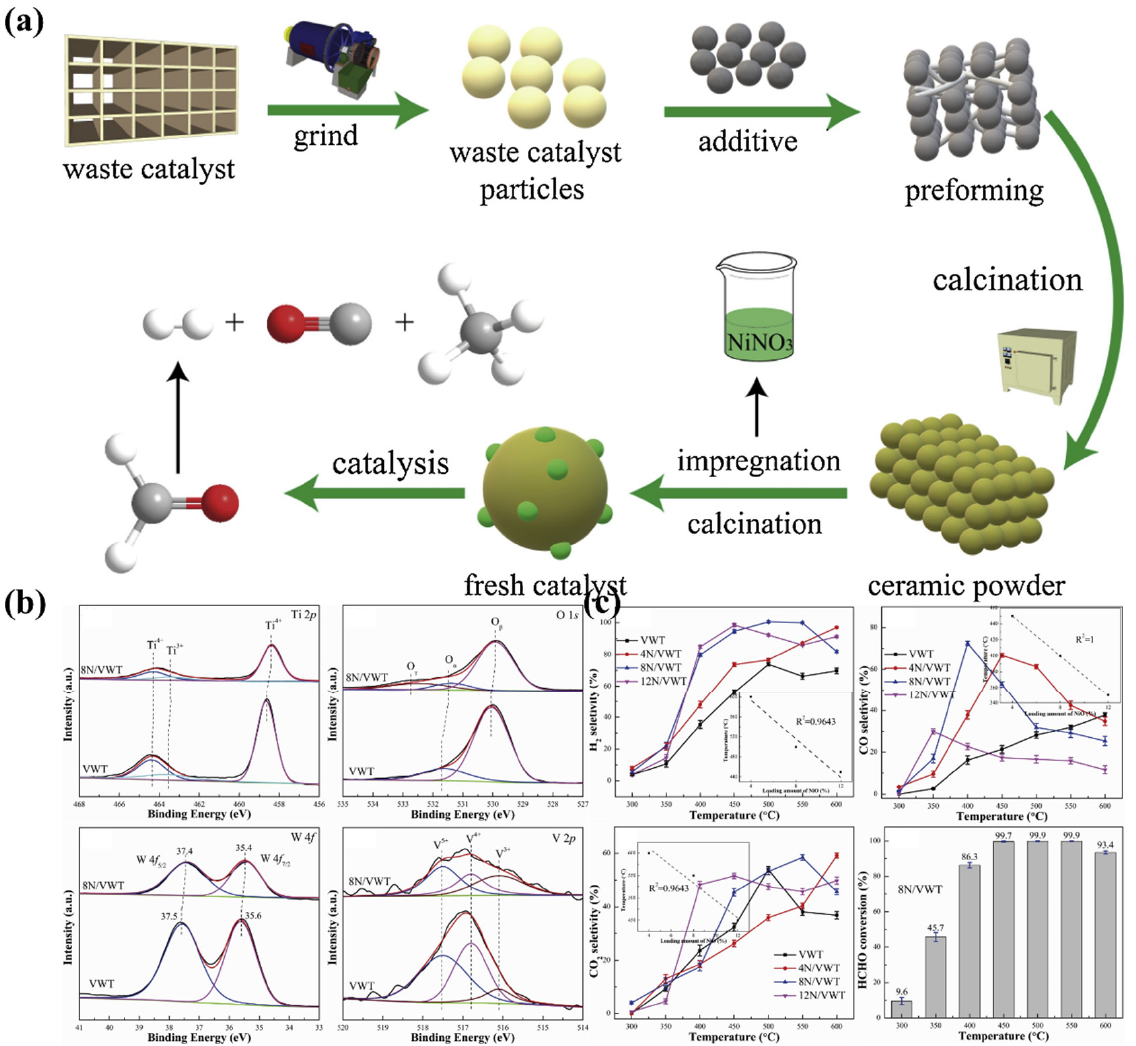
Figure 5. ( a ) Process of converting spent SCR catalysts into NiO-based catalysts, ( b ) XPS test results of spent SCR catalysts after sintering into ceramics, ( c ) catalytic performance test results of NiO-based catalysts. Reproduced with permission [70]. Copyright 2020, Elsevier.